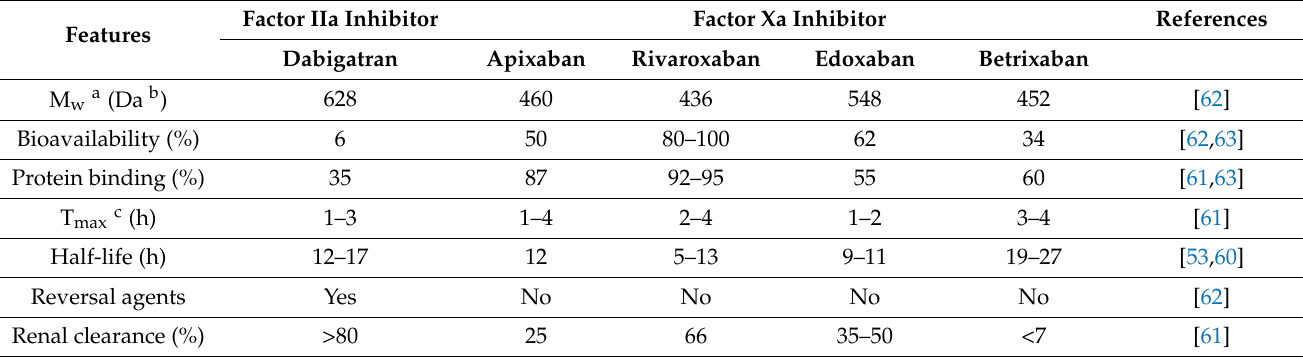
Table 2. Pharmacokinetic and pharmacodynamic properties of